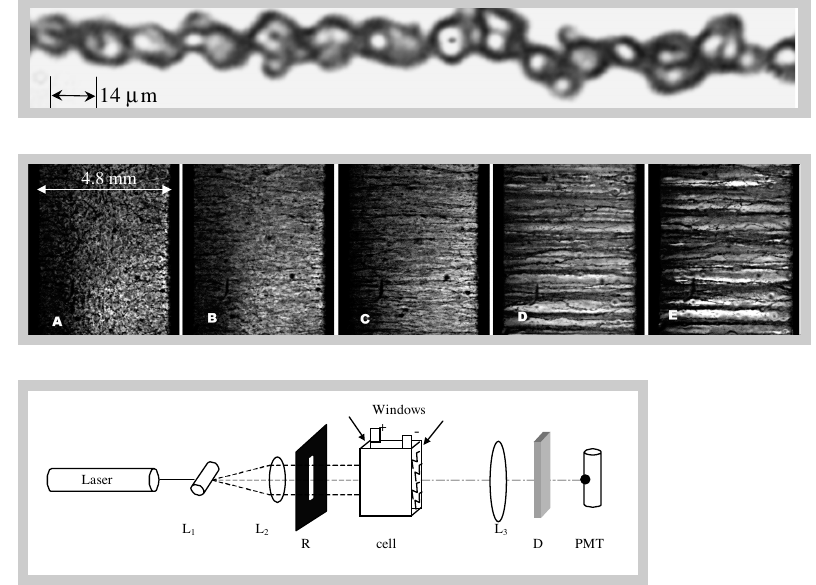
Figure 3 (above): Chain of cornstarch particles. Mean diameter ª 14 m m. An optical microscope of low power was used. Figure 4 (middle): Photographic sequence which shows image of FER inside the cell, near its exit window: a) initial state without applied electric field. b) state just after electric field was applied. c) 0.04 second after the field was applied. The formation chains are observed. d) intermediate state after 4 seconds. Column formations are taking place. e) stationary state after 10 seconds. Induced structures (columns) are fully developed. Figure 5 (below): Experimental set-up for transmittance measure- ments. L 1 , cylindrical lens; L 2 , collimating lens; R, slit; L 3 focusing lens; D, diffuser; PMT, photomultiplier